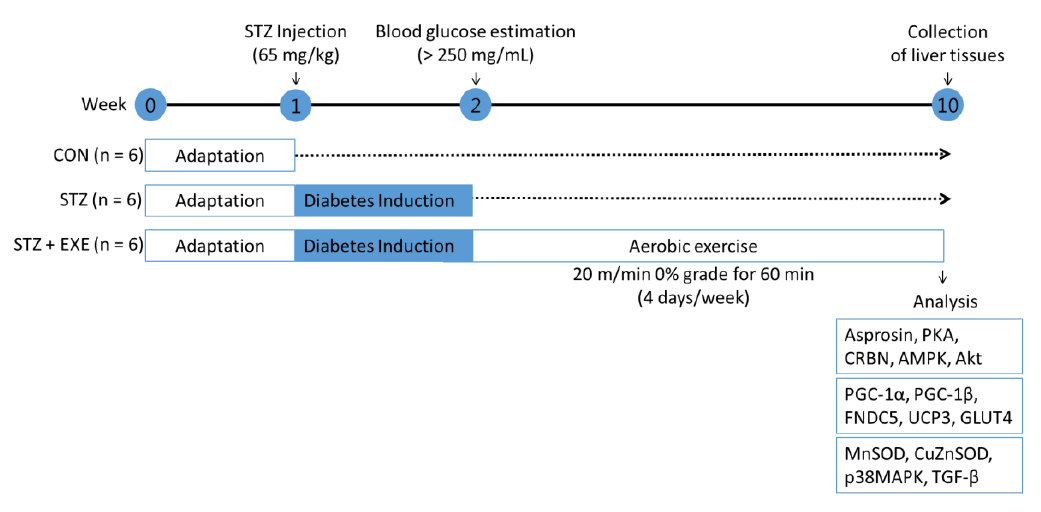
Figure 1. Schematic diagram of the experimental timeline. CON: control, STZ: streptozotocin, EXE, exercise.